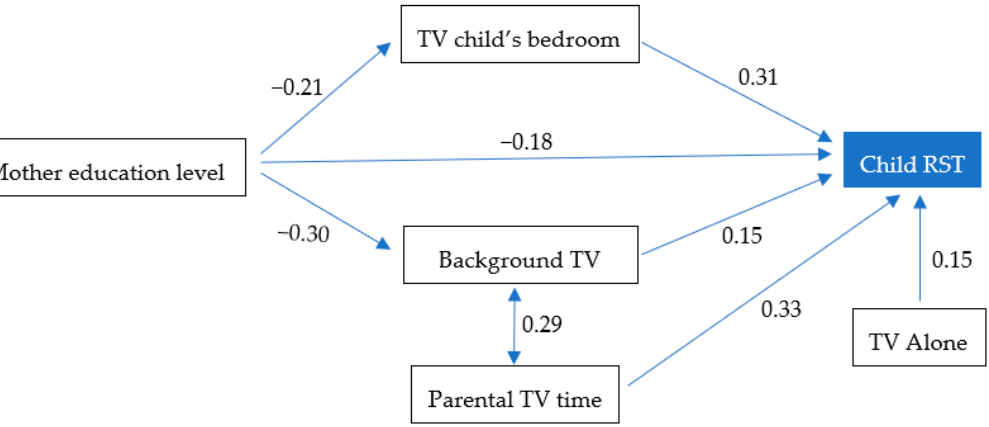
Figure 2. Final Path Model for the younger group (2–6 years-old) with standardized regression coefficients and correlations between variables. Proportion of variance explained: 38%. Fitting parameters: χ 2 = 8.175, df = 6, p < 0.01; RMSEA < 0.01; CFI = 1; TLI = 0.95. TV, television; RST, recreational screen time; RMSEA, root means square error of approximation; CFI, comparative fit index; TLI, Tacker-Lewis index.